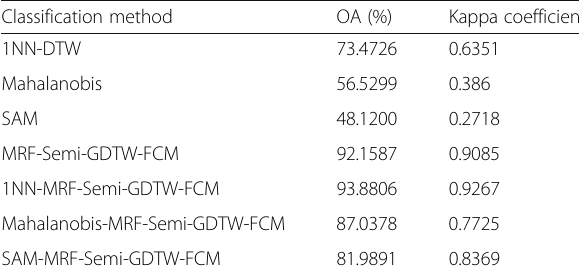
Table 2 Comparison of classification accuracy for fusion of different pixel classifications and MRF-Semi-GDTW-FCM Classification